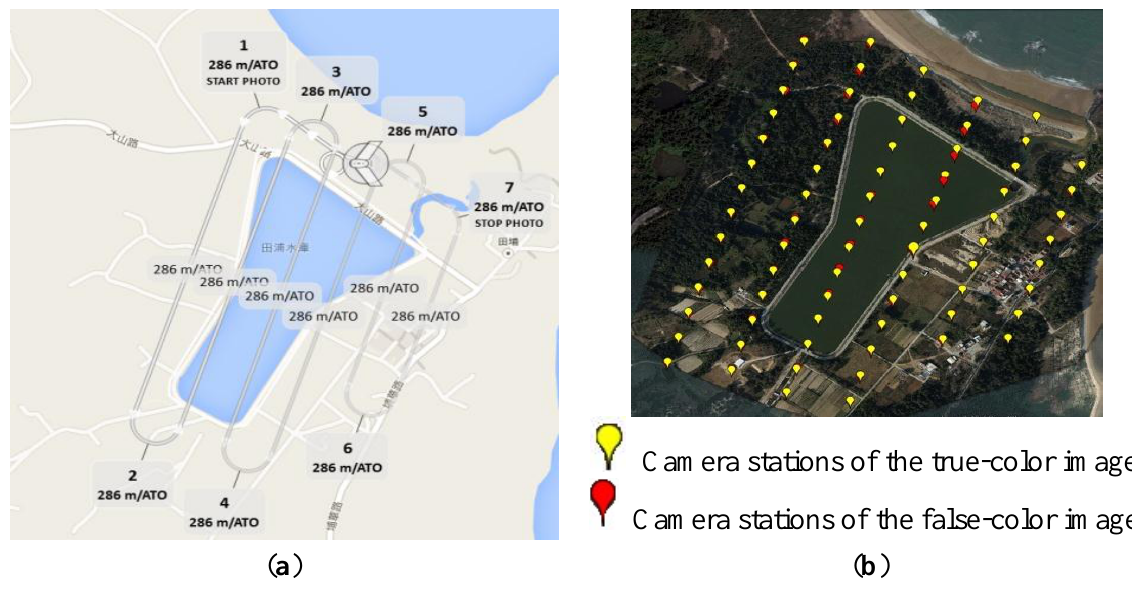
Figure 5. ( a ) Planned flight path where UAV imaging was started at position 1 and ended at position 7; ( b ) Locations of 73 schemed camera stations (single